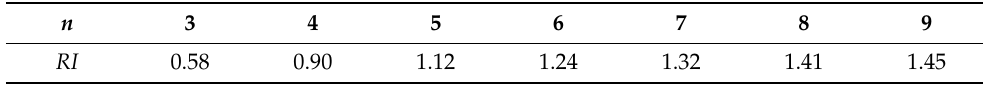
Table 6. RI values of the judgment matrix with low